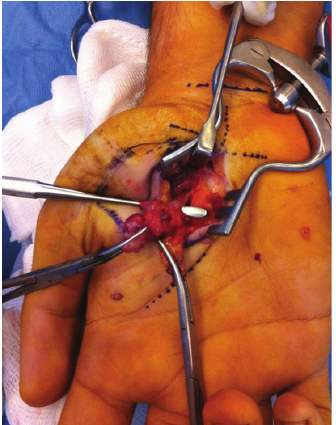
Figure 2: Lesion was excised with microscopic